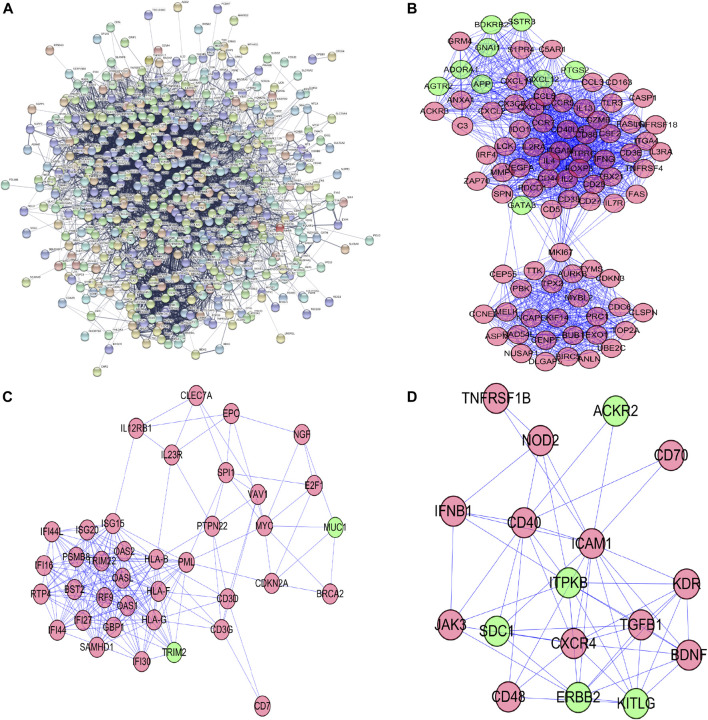
Protein–protein interaction network and its top 3 key modules analysis; (A) Protein–protein interaction network of differentially expressed apoptosis-related genes; (B) key module 1 from PPI network; (C) key module 2 from PPI network; (D) key module 3 from PPI network.